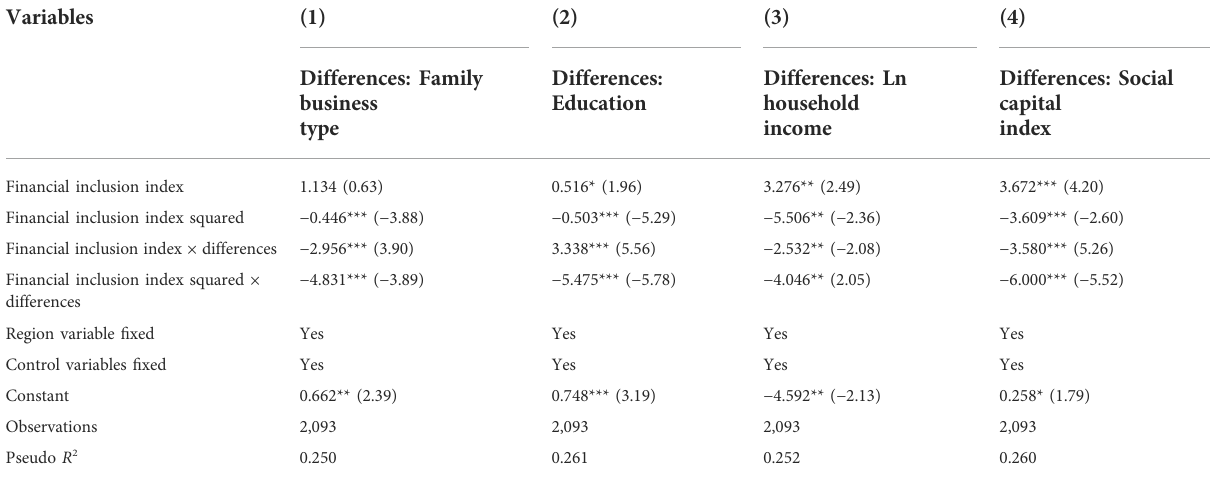
TABLE 8 Heterogeneous effects of fi nancial inclusion on household economic